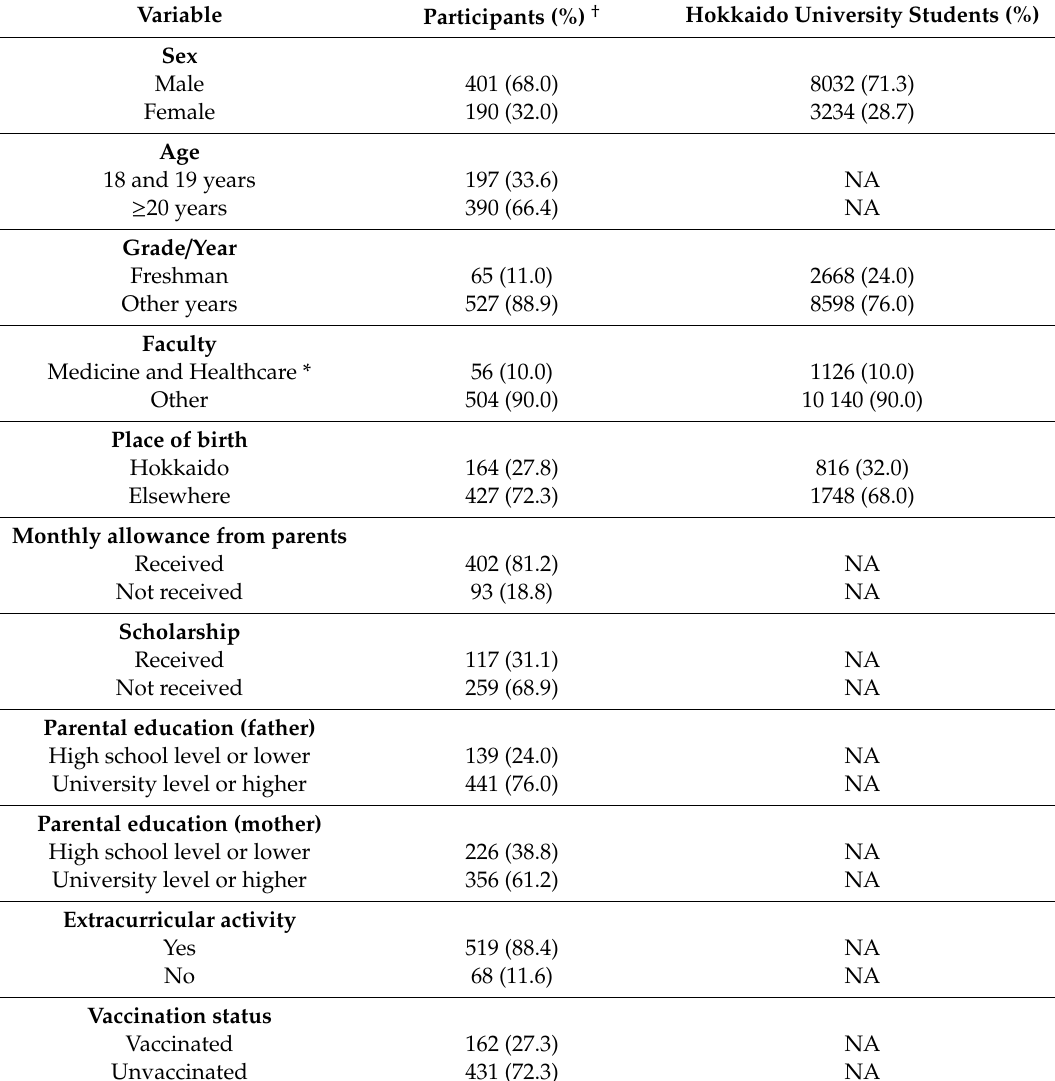
Table 1. Characteristics of the study participants ( n =